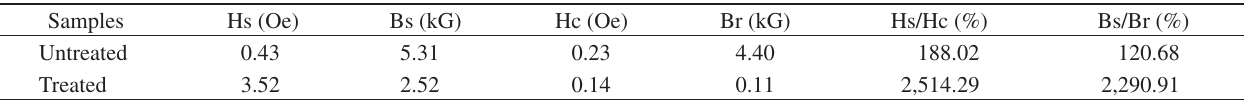
Figure 4. Representative curve of the variation of applied field vs. induced field, of alloy Co Fe Si B , in the as-cast condition, at a frequency of 67.5 3.5 17.4 11.6 7.5 kHz. Table 3. Magnetic properties of the alloys obtained from the hysteresis curve in the as-cast and stress annealed conditions in alloy 1, with f = 7.5 kHz. Samples